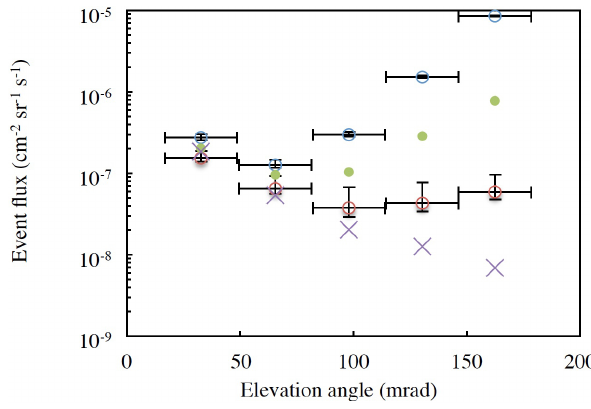
Figure 14. Elevation angle dependence on averaged event flux ob- served at Shinmoe-dake and Satsuma–Iwo Jima. The flux was aver- aged between azimuth ranges from − 430 to 430mrad for Shinmoe- dake and from 0 to 400mrad for Satsuma–Iwo Jima. The backward- directed (open sky) and forward-directed (mountain side) flux is shown for Shinmoe-dake and Satsuma–Iwo Jima with blue and red triangles and blue and red circles, respectively.